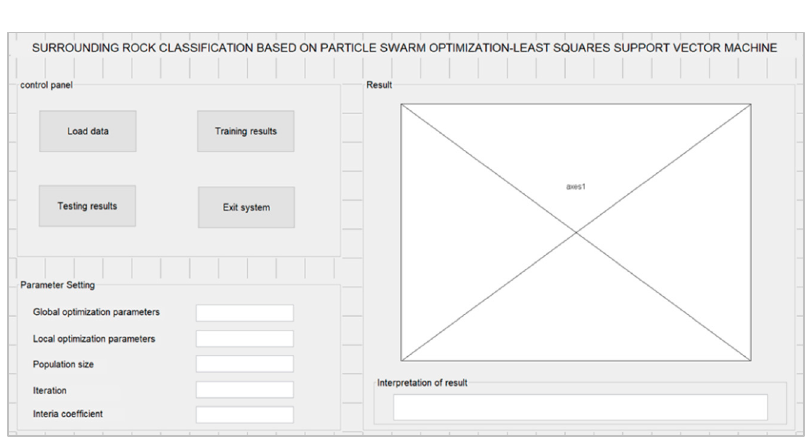
Figure 5. Matlab dynamic surrounding rock grading interface.